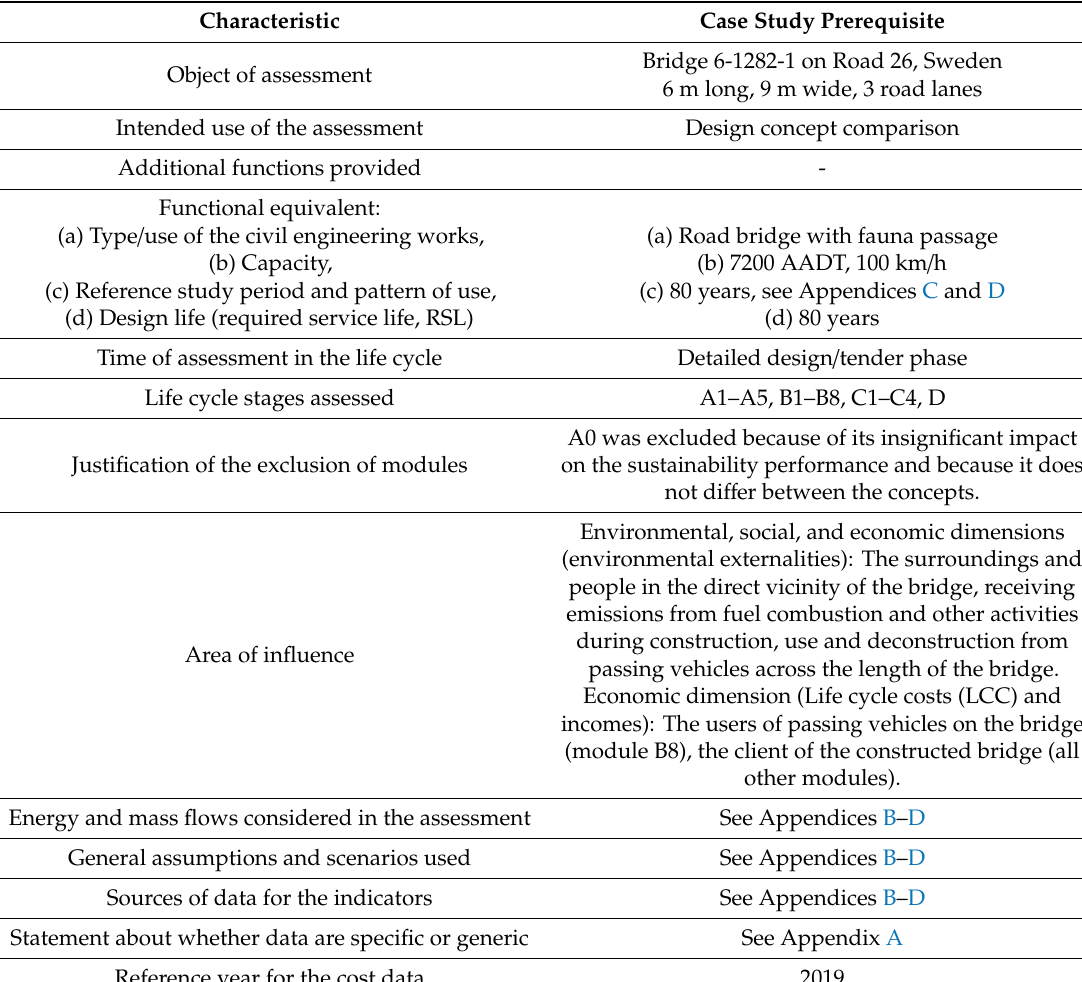
Table 1. Case study specific prerequisites for the